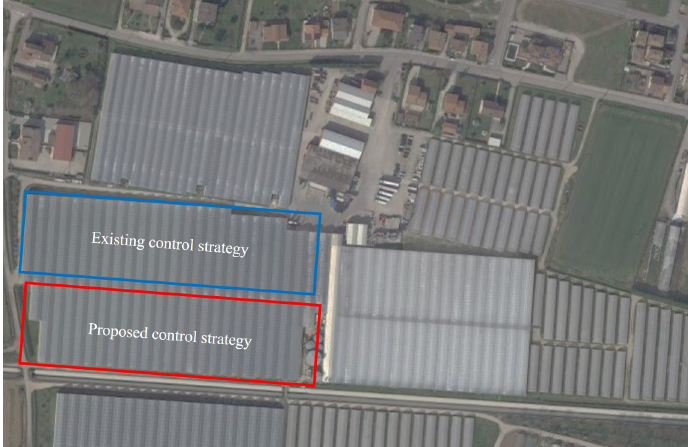
Figure 1. Overview of the greenhouse where the experimental setup was